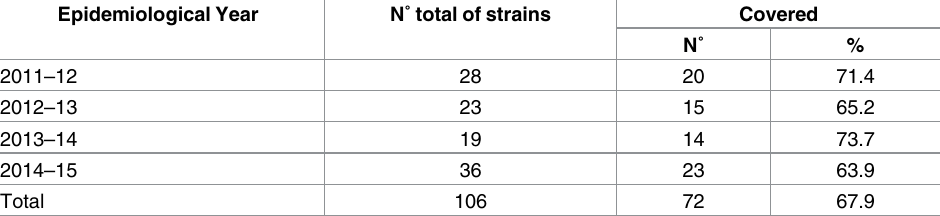
Table 1. Number of invasive B stains isolated in Portugal from the first July 2011 to 30 th June 2015, and 4CMenB strain coverage predicted by MATS.